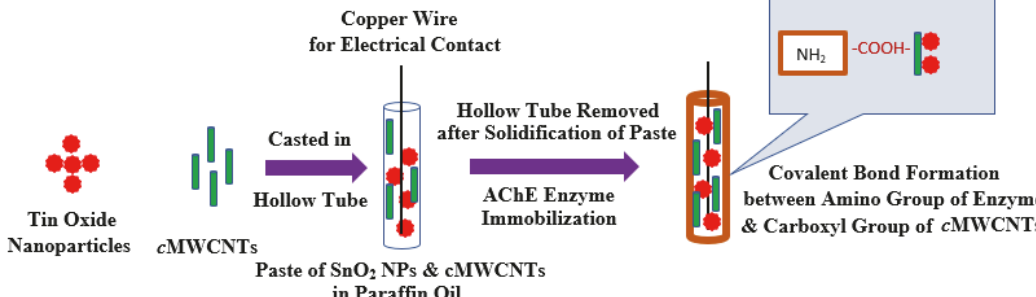
Figure 1: Fabrication strategy of working electrode of developed sensor.